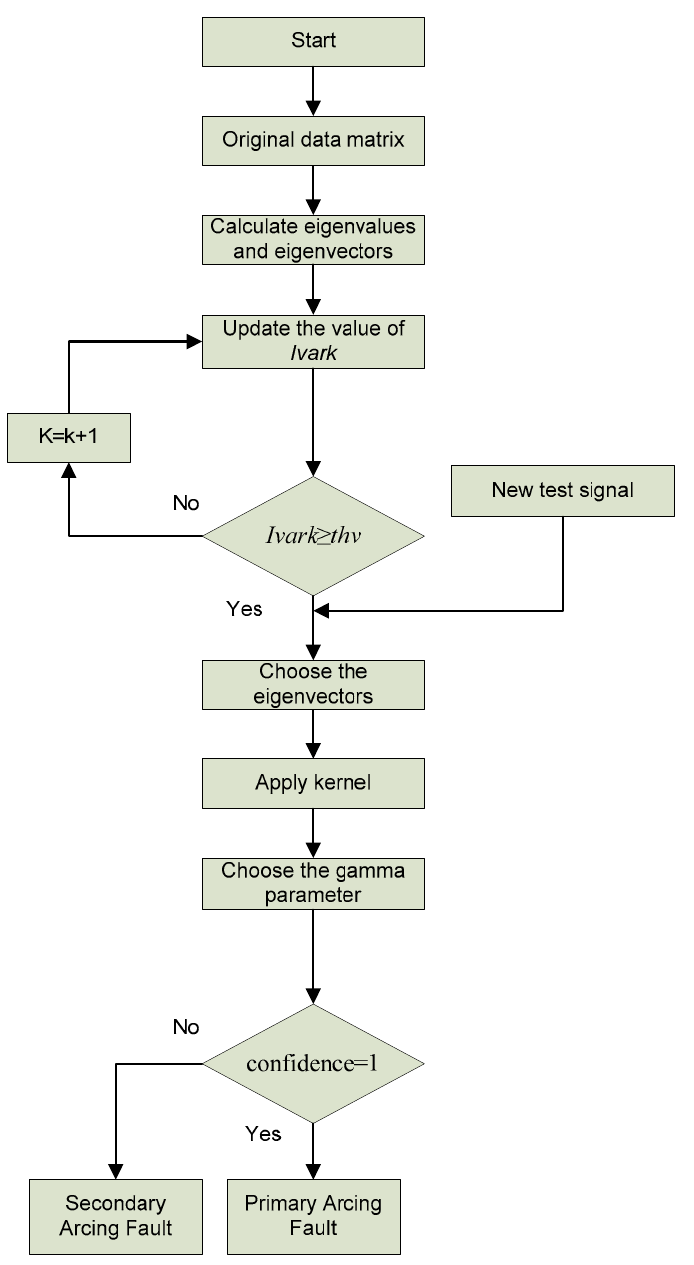
Figure 13. Flow chart of the proposed method.